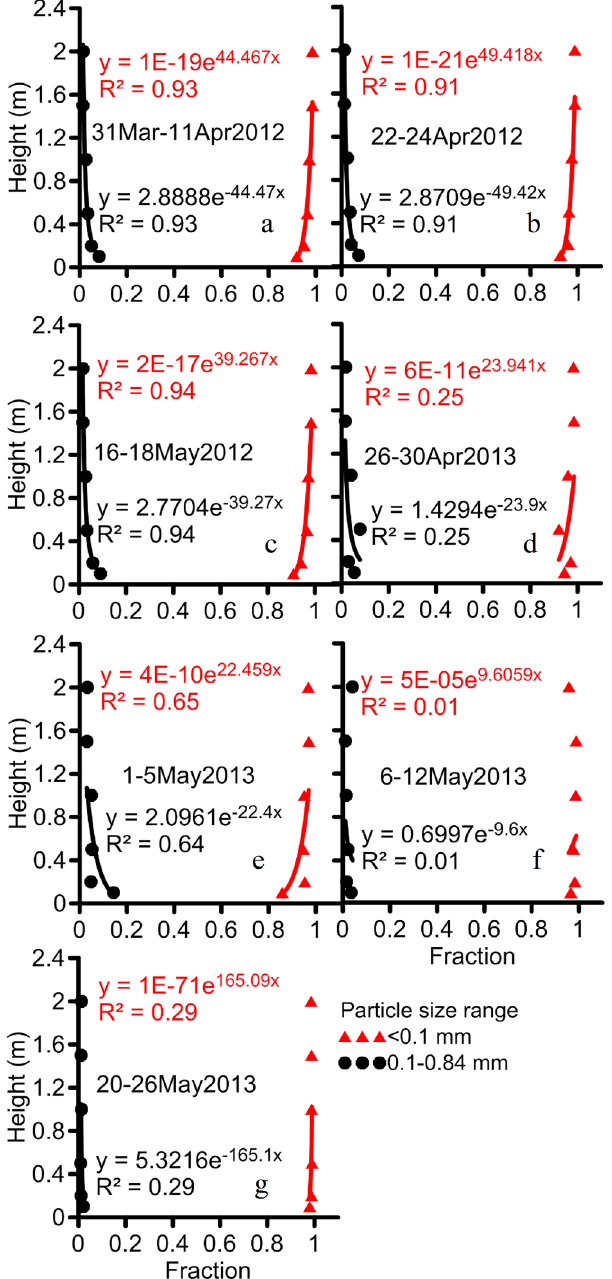
Figure 3. Size distribution of sediment trapped by BSNE collectors during 7 high wind events. Sediment was trapped by BSNE collectors positioned at six heights (0.025–2